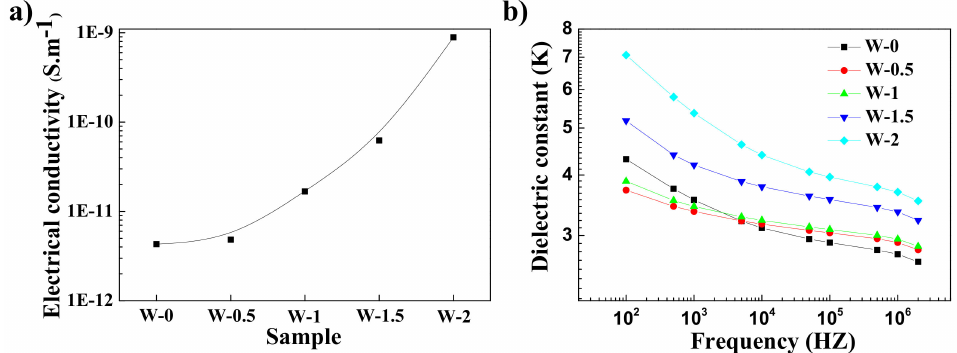
Figure 10. ( a ) Electrical conductivity and ( b ) dielectrical constant of rGO / 60SiO 2 / NR composites made by the WCL